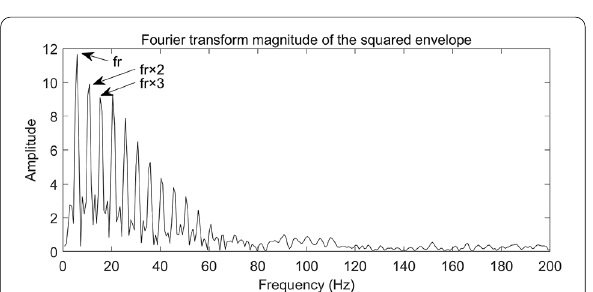
Figure 12 The squared envelope spectrum of the processed signal based on KM